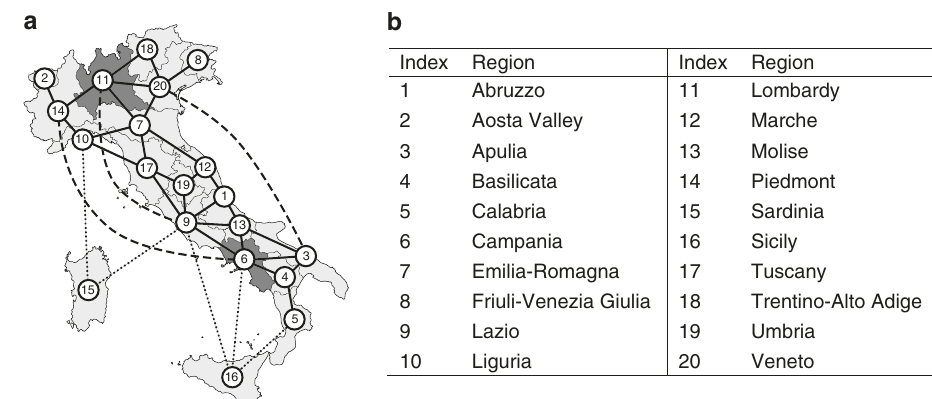
Fig. 1 Schematic diagram of the network-model structure and representative regional parameters. a Representative graph of the network-model structure used in the paper. Only a subset of all links is shown for the sake of clarity (the complete graphs are depicted in Supplementary Fig. 8). Solid lines represent proximity links, dashed lines long-distance transportation routes (planes and trains), dotted lines show major ferry routes between insular regions and the Italian mainland. b Table of the Italian region names and their labels in